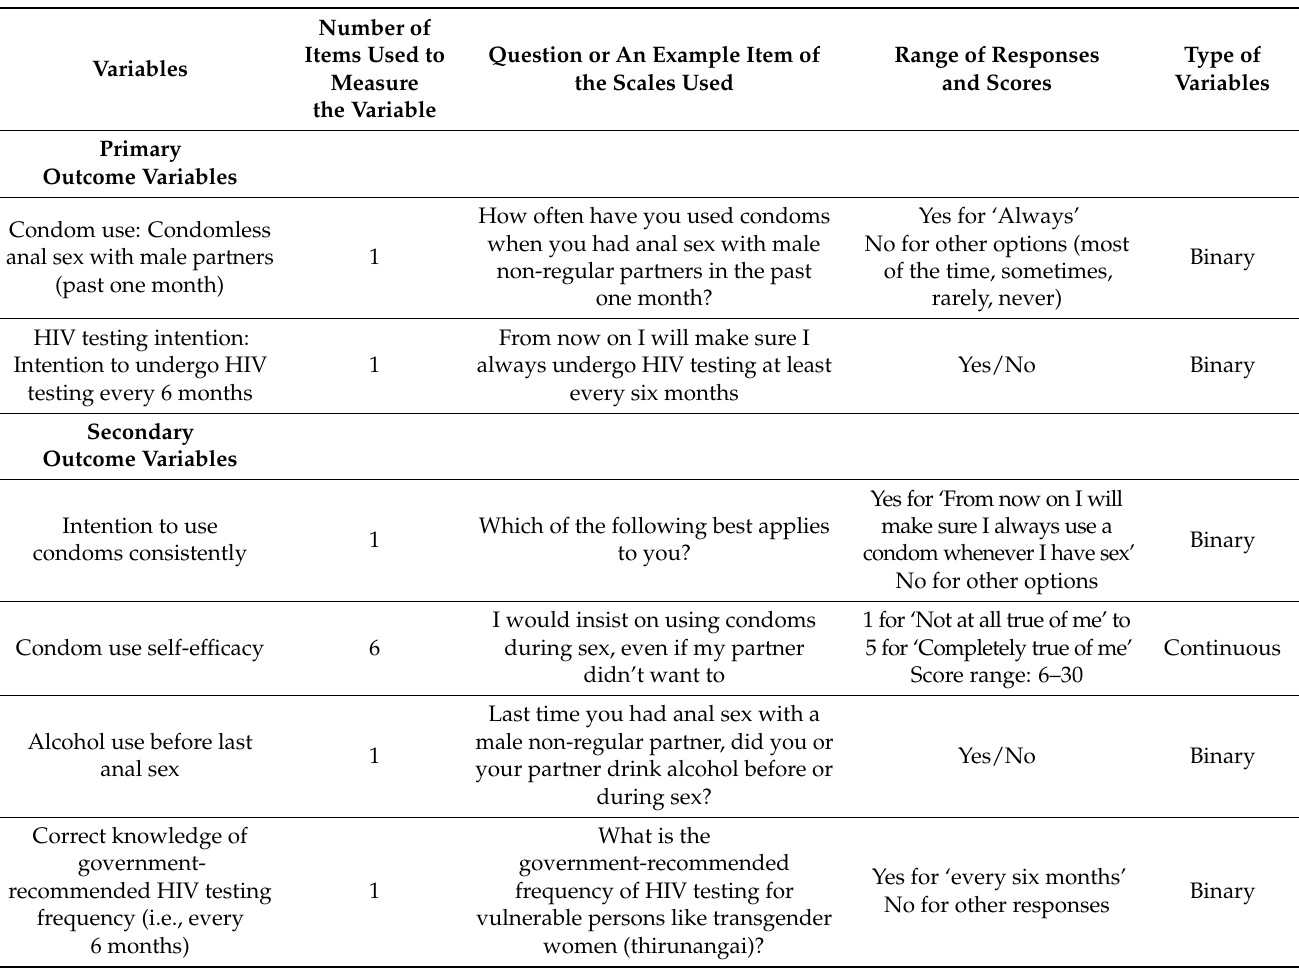
Table 2. Summary of the study’s key outcome and predictor